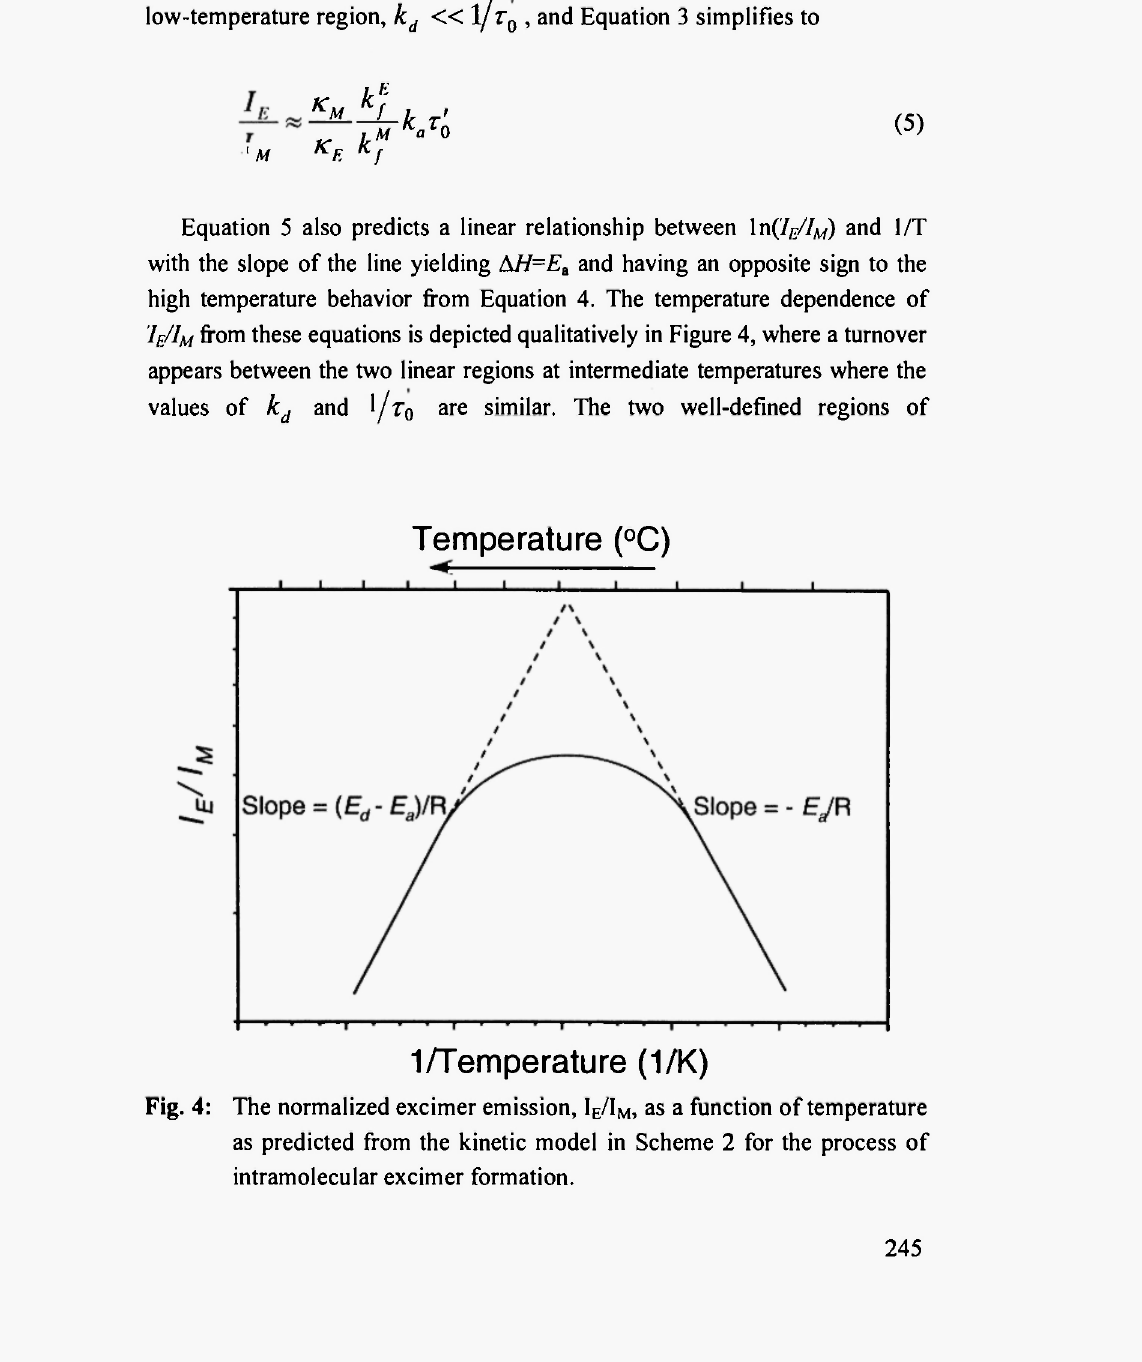
Fig. 4: The normalized excimer emission, I E /I M , as a function of temperature as predicted from the kinetic model in Scheme 2 for the process of intramolecular excimer